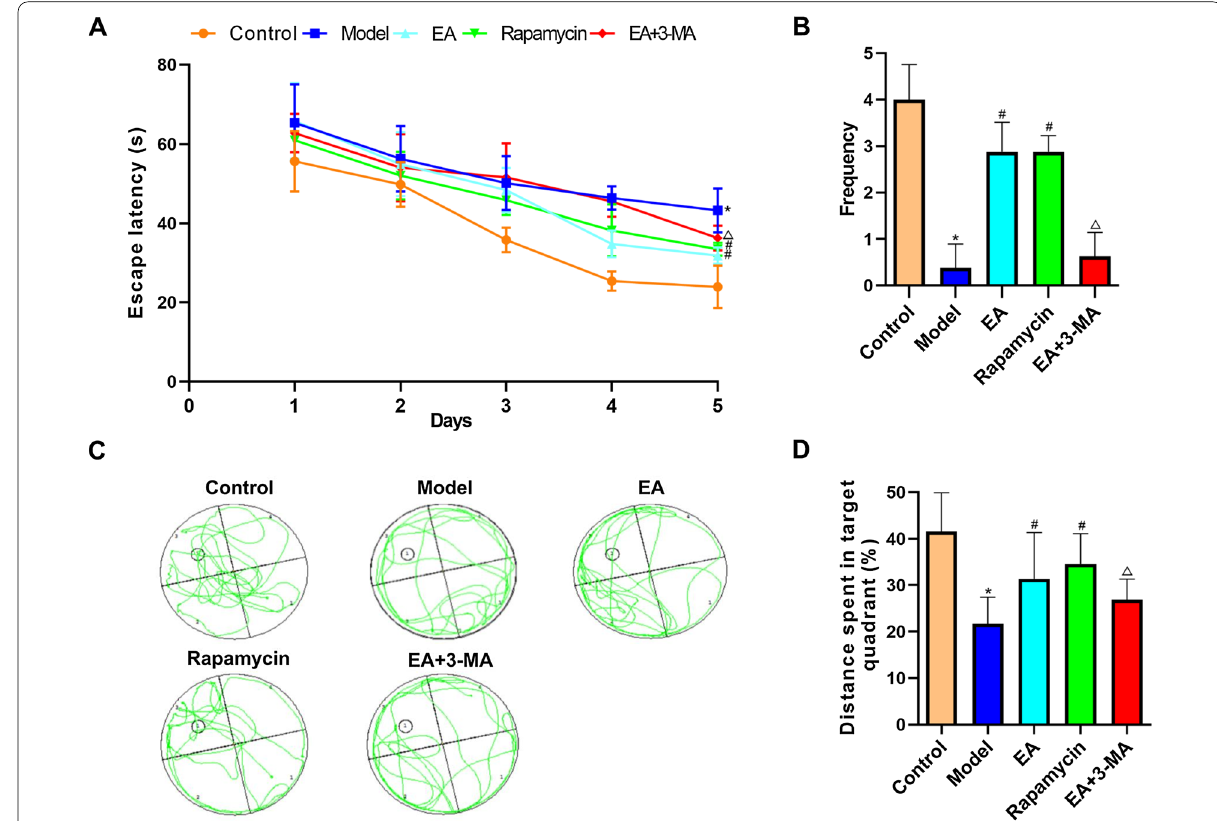
Fig. 3 Effect of EA on learning and memory in diabetic rats with cognitive impairment by the Morris water maze test. a Escape latency, and b swimming trajectories were recorded to assess the learning ability. c Number of platform crossings and d percentage of distance that the rats in the target quadrant. All data are expressed as means